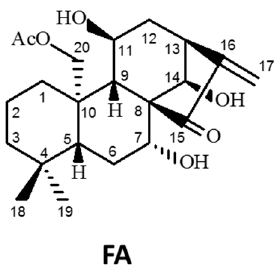
Figure 1. The chemical structure of ent -kaurane diterpenoid flexicaulin A (FA).